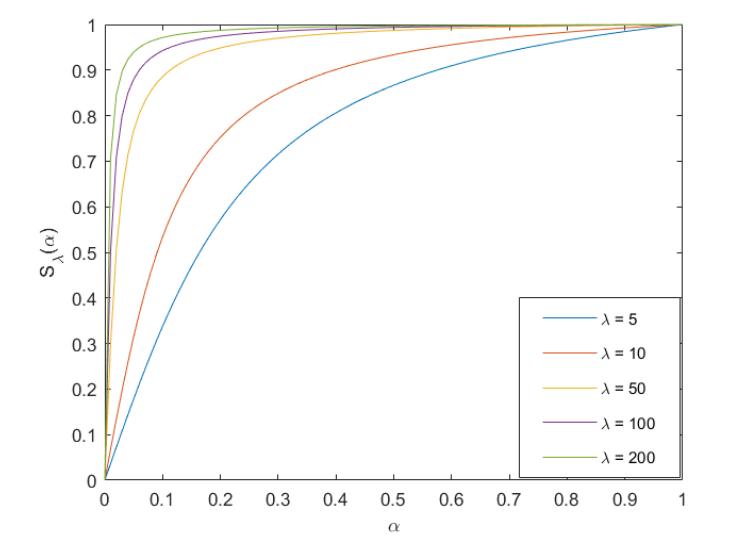
Figure 7. Nonlinear